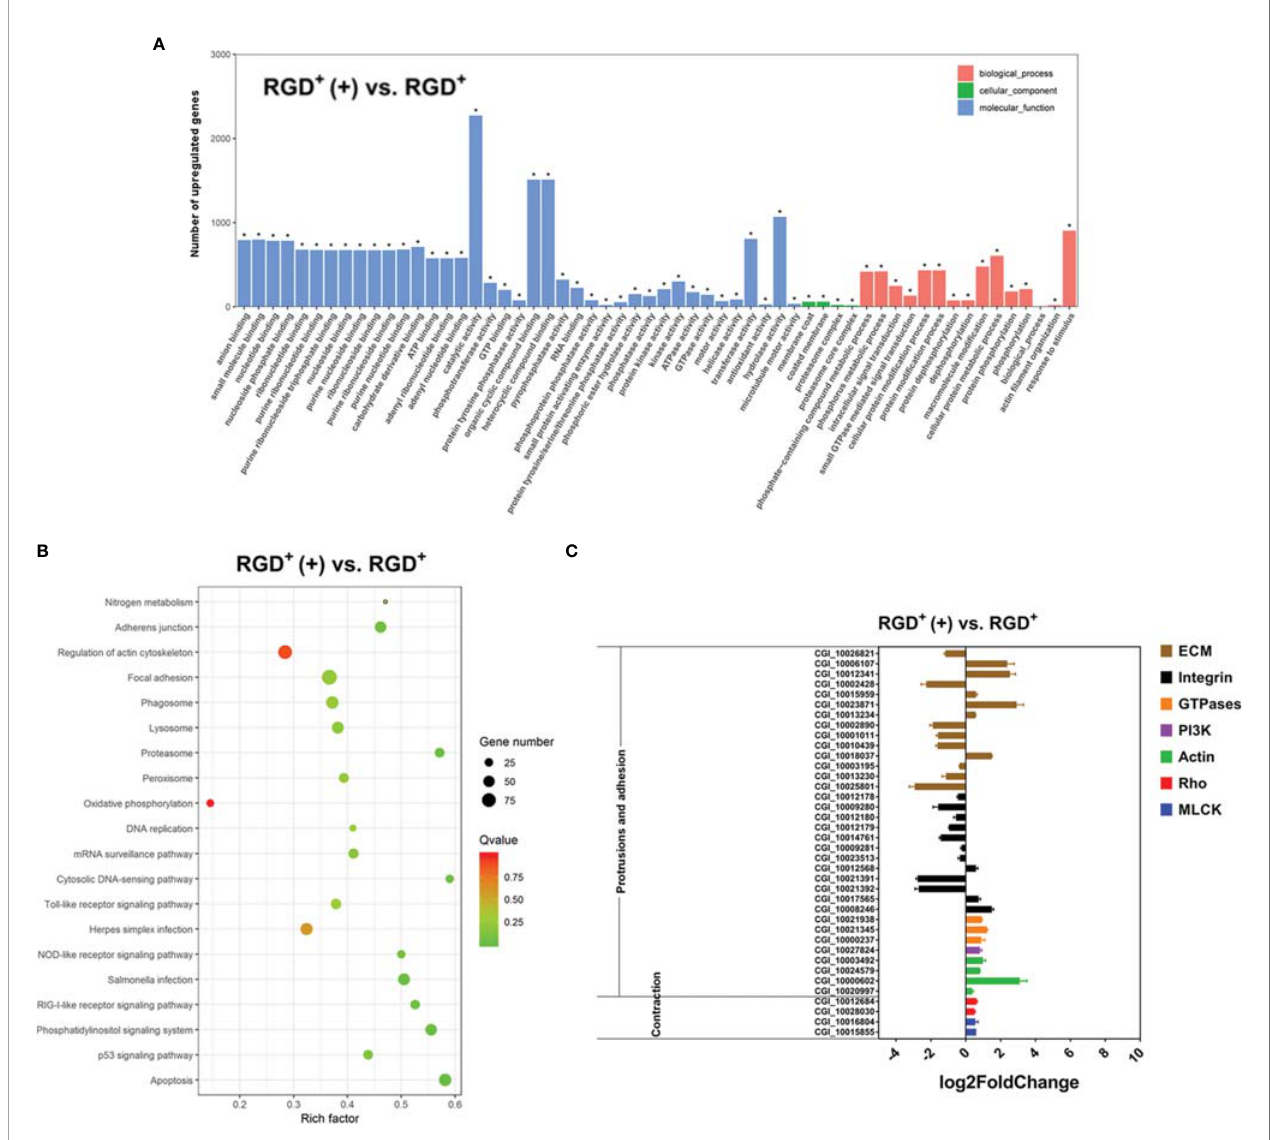
FIGURE 6 | Transcriptome analysis revealing the molecular basis of the enhanced C. gigas RGD + hemocyte migration in response to V. splendidus infection. (A) Top 60 GO terms enriched in the signi fi cantly upregulated genes in the activated RGD + hemocytes compared to the resting RGD + hemocytes. (B) Top 20 KEGG pathway items enriched in the signi fi cantly upregulated genes in the activated RGD + hemocytes compared to the resting RGD + hemocytes. (C) qPCR validation of the selected 38 DEGs involved in the formation of protrusions and fi rm adhesions at the front and contractions at the rear in the activated RGD + hemocytes compared to the resting RGD + hemocytes. RGD + and RGD + (+) represent the resting RGD + and the activated RGD + hemocytes, respectively. The asterisk (*) stands for statistical signi fi cance at p <